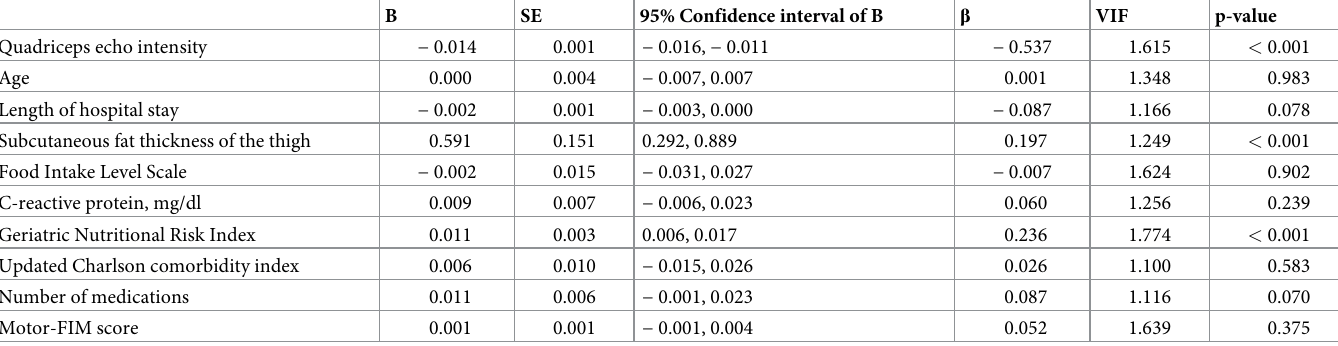
Table 2. Multiple regression analysis for muscle thickness in male model with forced entry method (n = 180).